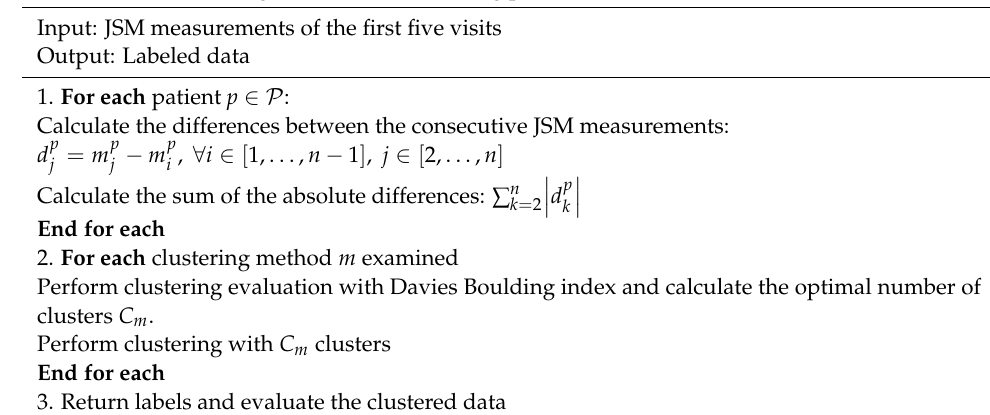
Algorithm 1 Pseudoalgorithm of the clustering